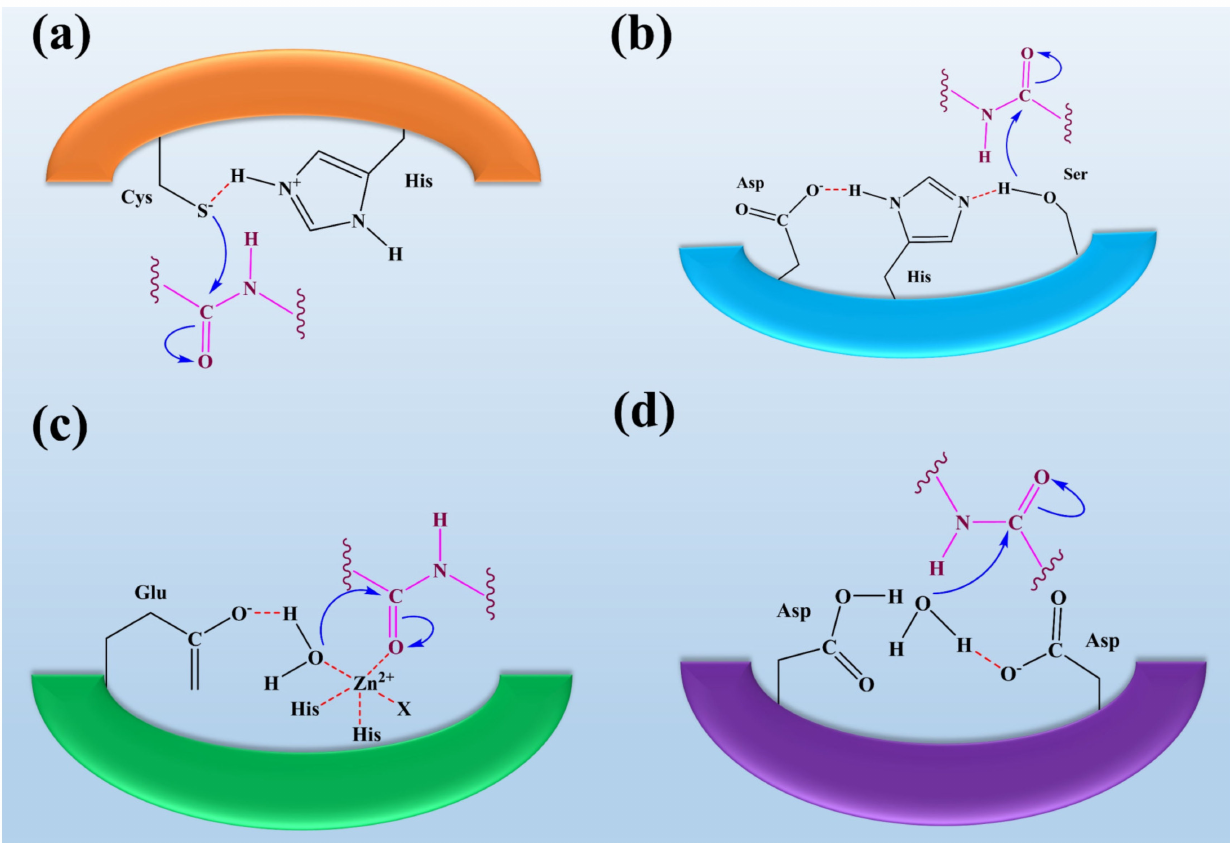
Figure 2. The representation of fungal protease mechanisms of ( a ) serine proteases ( b ) aspartyl proteases, ( c ) metalloproteases, and ( d ) cysteine proteases. It was reported that the eponymous residue is commonly formed as a pair with a proton withdrawing group in the active sites of cysteine and serine proteases to promote a nucleophilic attack on the peptide bond. In contrast, metalloproteases and aspartyl proteases activate water molecules as nucleophiles. Overall, it was observed that the process of peptide bond scission is the same for all classes of proteases. This figure is reproduced from Erez et al. [135] after permission from Springer Nature (License No.